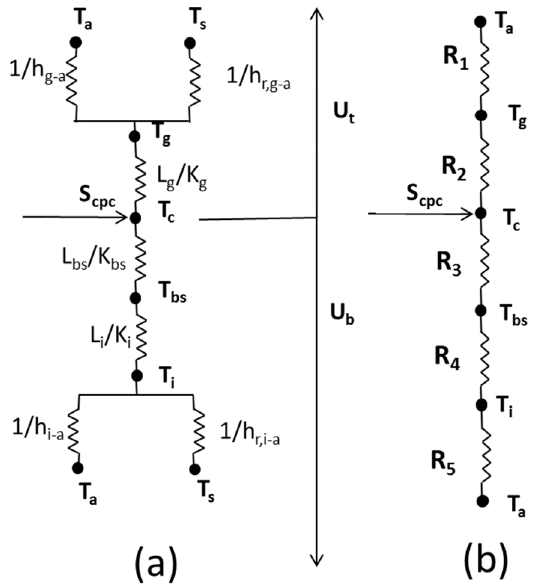
Figure 3. Thermal network for V-trough PV system without cooling ( a ) in terms of conduction, convection and radiation resistances; ( b ) in terms of resistances between plates.